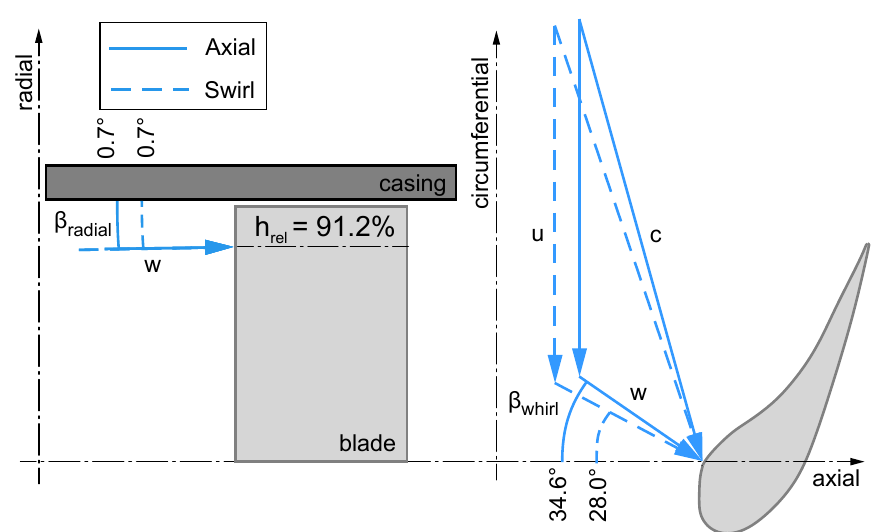
Figure 3. Velocity triangles with rotor relative angles β radial and β whirl at the rotor tip for axial inflow (solid lines) and swirling inflow (dashed lines) at a relative channel height of h rel =